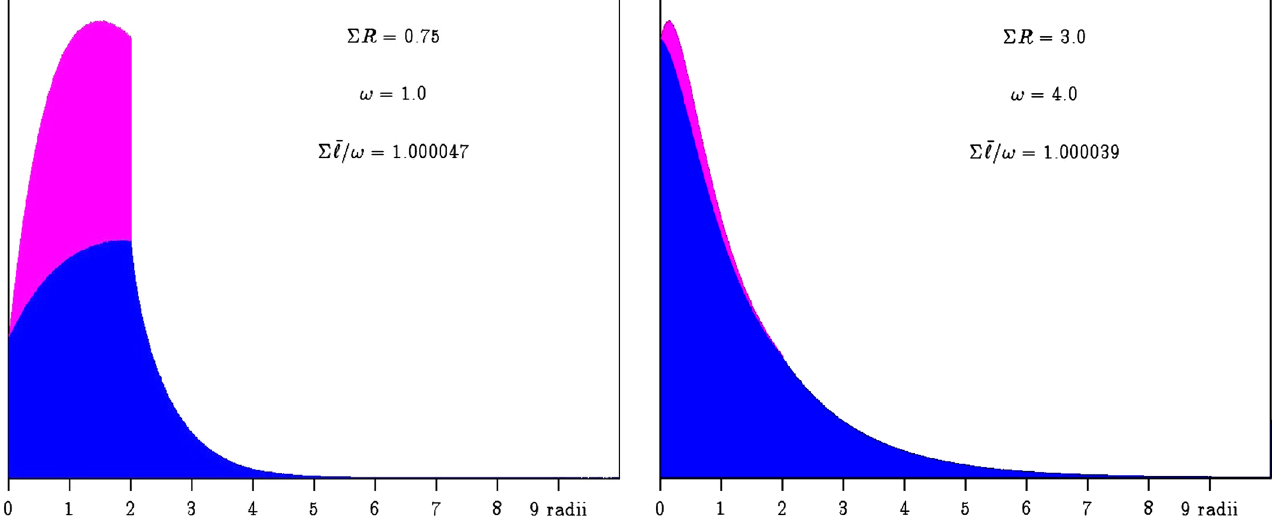
Fig. 3. Distribution of the lengths travelled by the particles for a sphere of opacity 1.